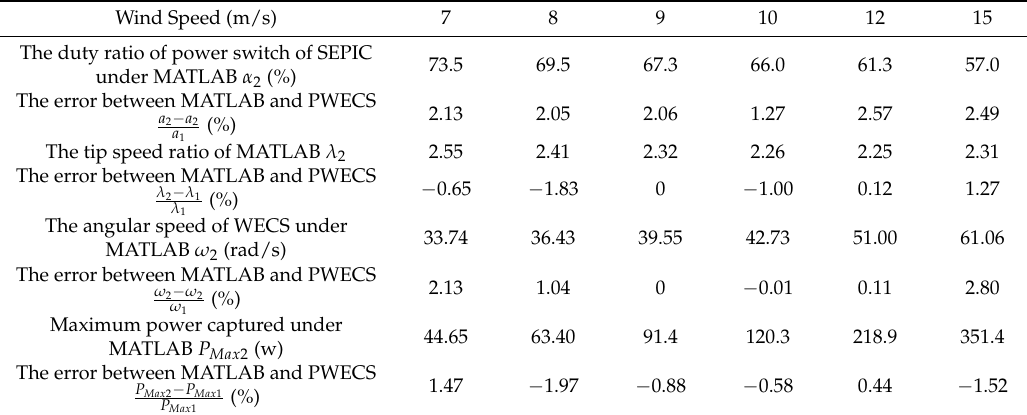
Figure 14. Curves between the maximum power and the duty cycle of power switch of SEPIC on the MATLAB platform: ( a ) when the wind velocity is 15 m/s; ( b ) when the wind velocity is 10 m/s; ( c ) when the wind velocity is 7 m/s. Table 2. The comparison of calculation results between PWECS and MATLAB